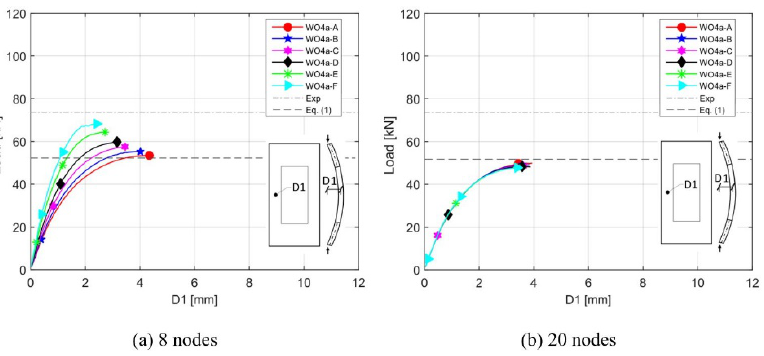
Figure 8. Out-of-plane displacement of non-strengthened models for different mesh sizes.